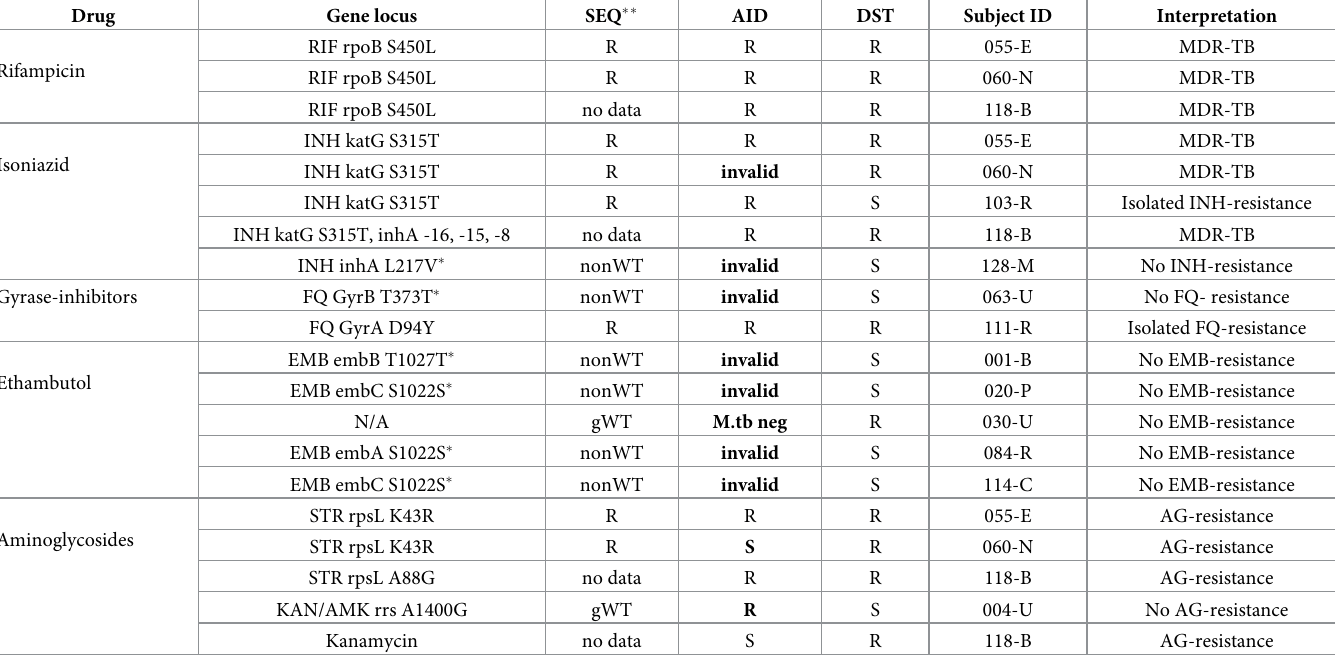
Table 4. Pattern of resistance results by all three tests: sequencing, AID modules and DST in culture. Drug Gene locus